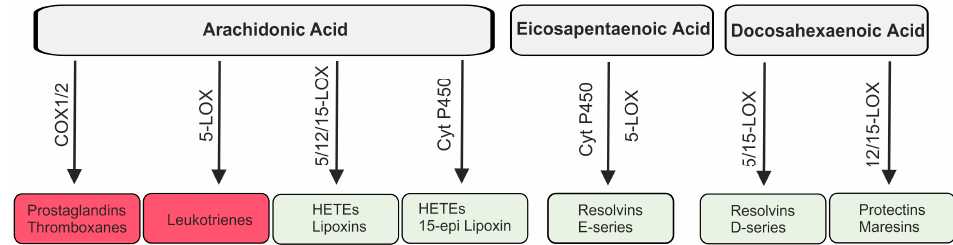
Figure 3. Lipids derived from arachidonic acid, eicosapentaenoic acid and docosahexaenoic acid.